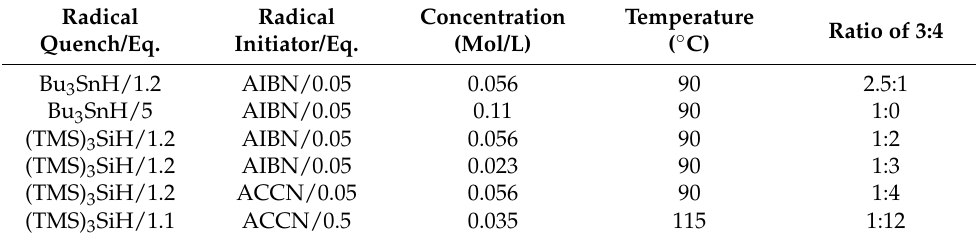
Table 1. Radical deoxygenation conditions (toluene was used as solvent in all reactions). Radical Quench/Eq. Radical Initiator/Eq. Concentration Temperature (Mol/L) Bu 3 SnH/1.2